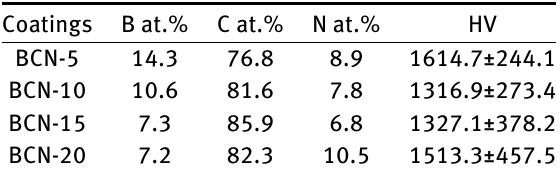
Table 1: Chemical composition and Vickers hardness of BCN coat- ings.